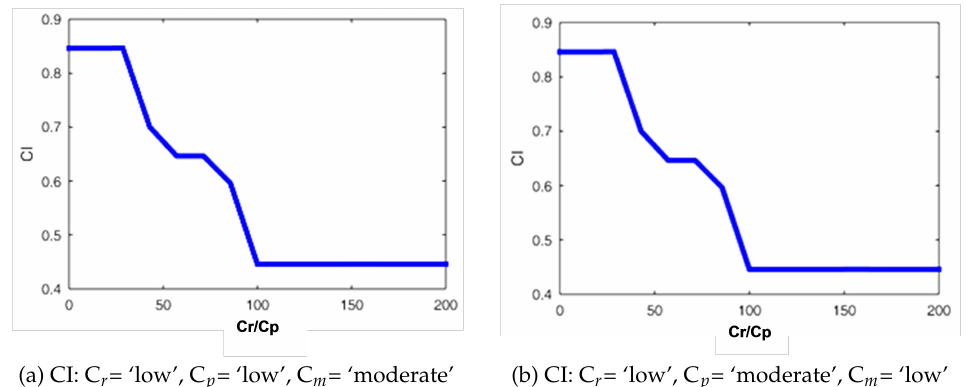
Fig. 7. Effect of costs interaction on varying cost implication decisions (type 2)